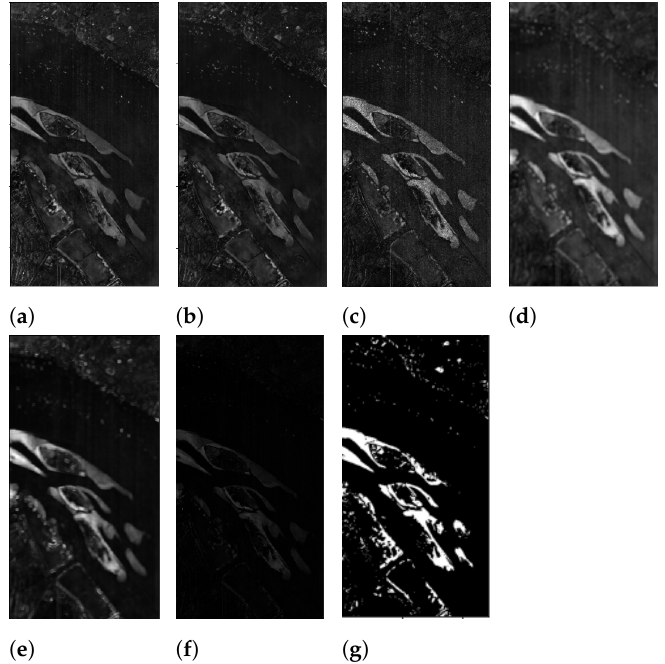
Figure 7. Results after line 2 in Algorithm 1 for the River dataset. ( a ) f 1 : Euclidean distance, ( b ) f 2 : Manhattan distance, ( c ) f 3 : SAM-ZID, ( d ) f 4 : SAM-MEAN, ( e ) f 5 : SMSADM, ( f ) f 6 : Pearson cc, ( g ) ground